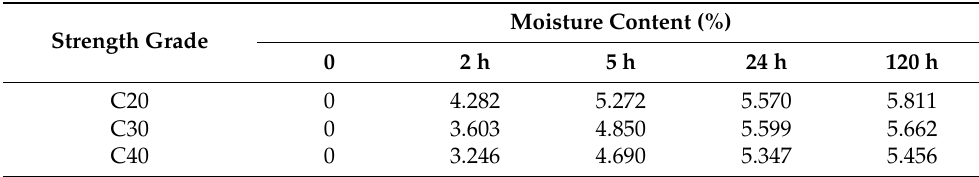
Table 3. Relationship between moisture content and soaking